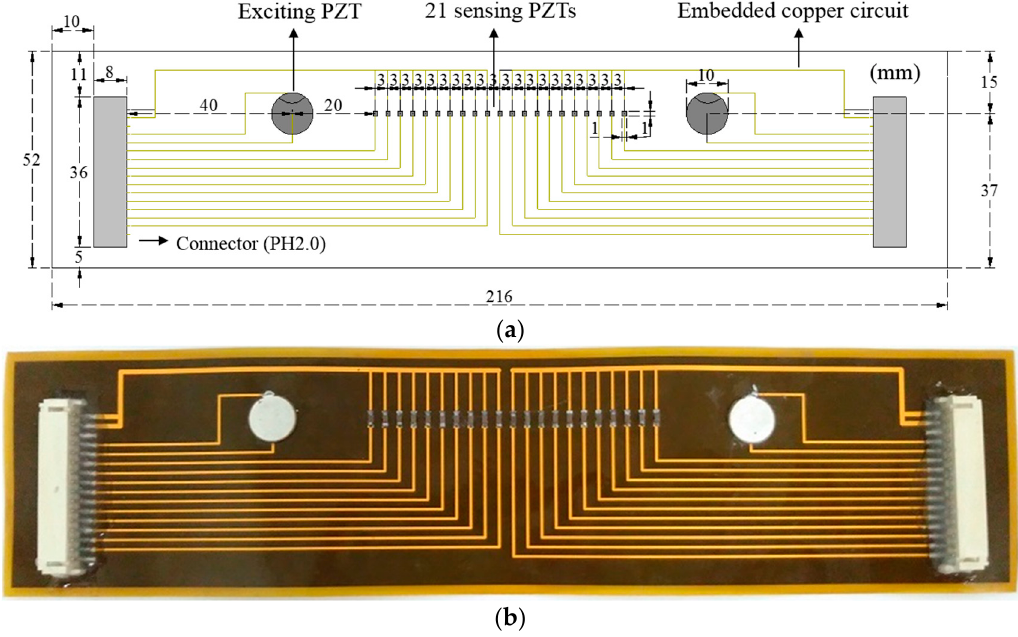
Figure 11. Stripe-PZT sensor design: ( a ) schematic design of the stripe-PZT sensor ( b ) actual stripe-PZT sensor manufactured with a flexible printed circuit board (PCB).